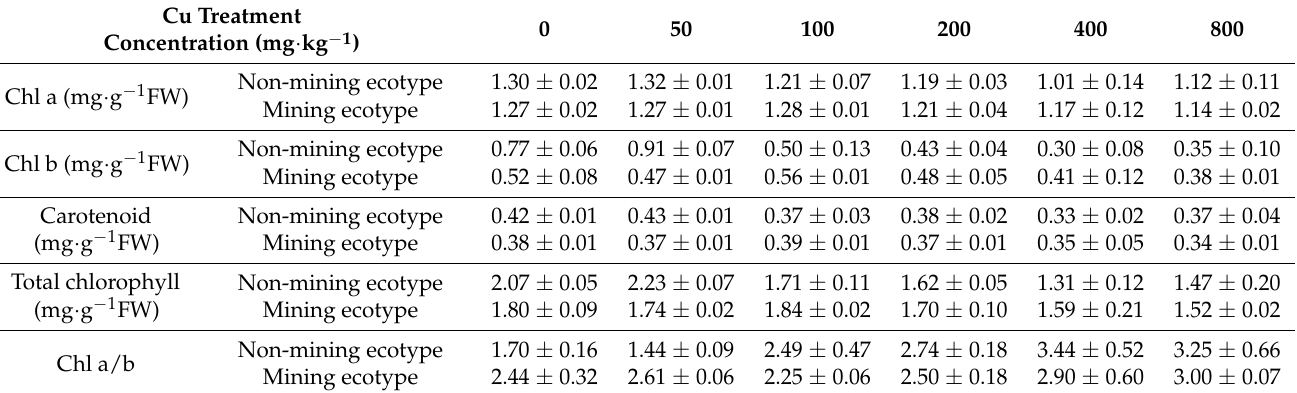
Table 2. Effect of different Cu treatment concentrations on chlorophyll content of two ecotypes. Cu